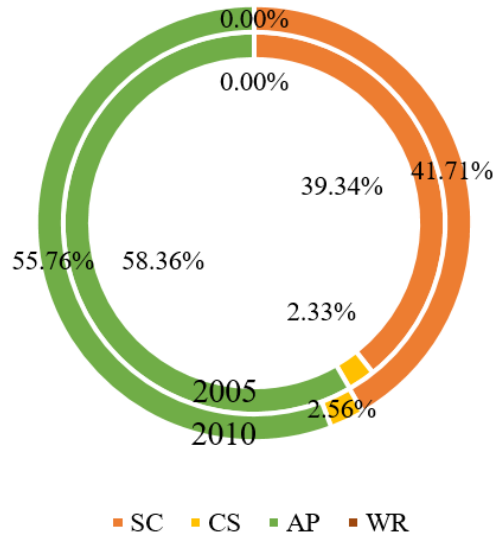
Energies 2020 , 13 , x FOR PEER REVIEW Figure 12. Changing trend of total ESs composition in Shanghai. Figure 12. Changing trend of total ESs composition in Shanghai.